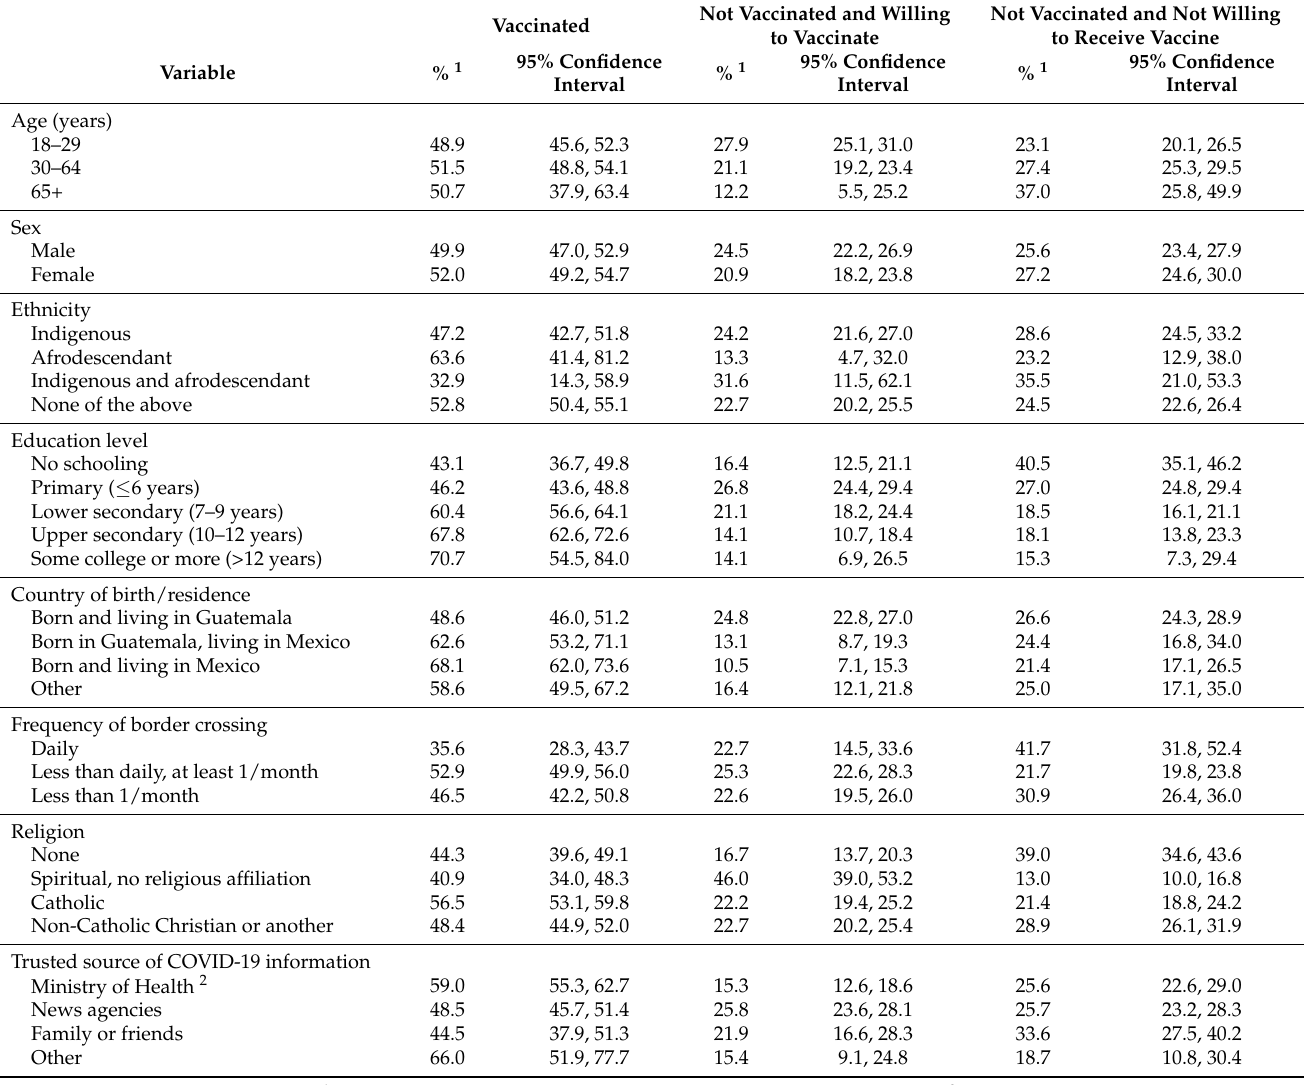
Table 3. Sociodemographic characteristics of participants, by vaccination status and willingness to be